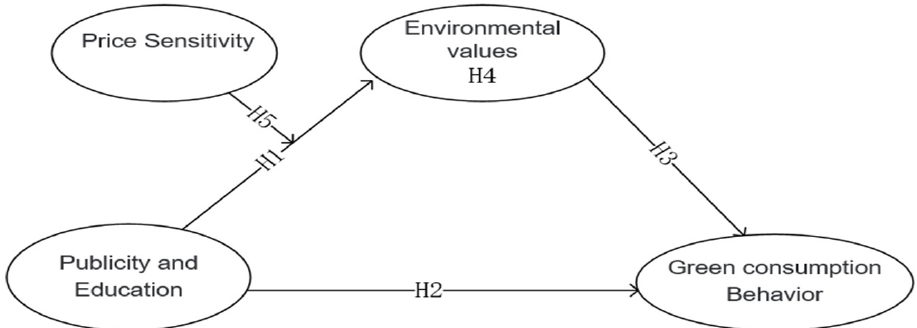
Figure 1. Conceptual model of the study. Note: H1 publicity and education positively affect en- vironmental values.H2 publicity and education positively affect individual green consumption behavior.H3 environmental values positively influence green consumption behavior. H4 environmen- tal values have a mediating effect on the influence of publicity and education on green consumption behavior.H5 price sensitivity has a negative moderating effect on the relationship between publicity and education and environmental values; when more consideration is given to the price of green consumption, the positive impact of publicity and education on environmental values is weak- ened, and the mediating effect of publicity and education on green consumption behavior through environmental values is weakened, and vice versa.